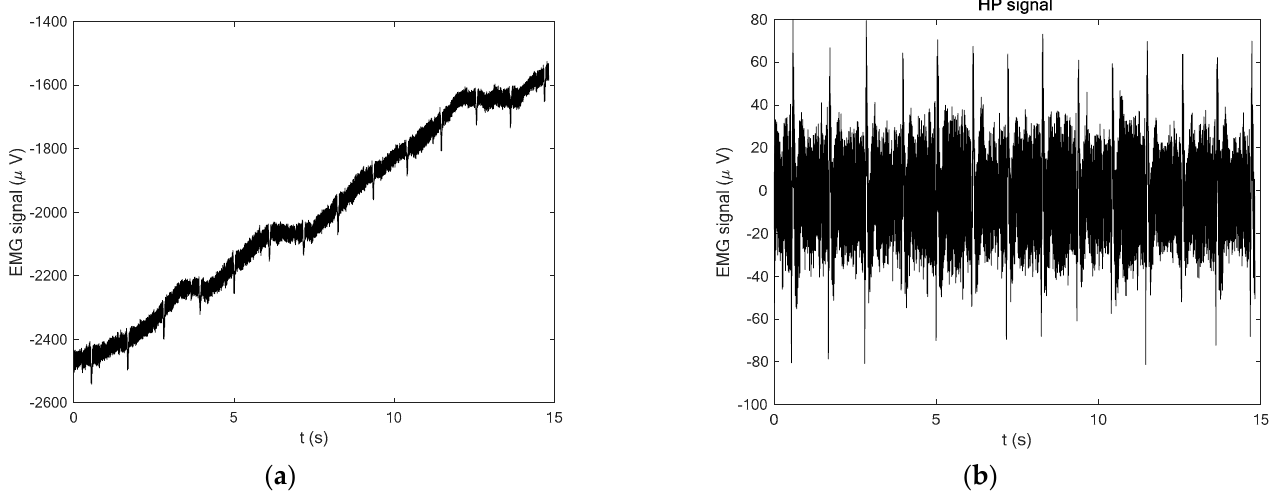
Figure 3. ECG signal measured on the right abdominal muscle, ( a ) raw signal ( b ) after removing low-frequency part using 3rd order Butterworth HP filter, f c = 2 Hz.